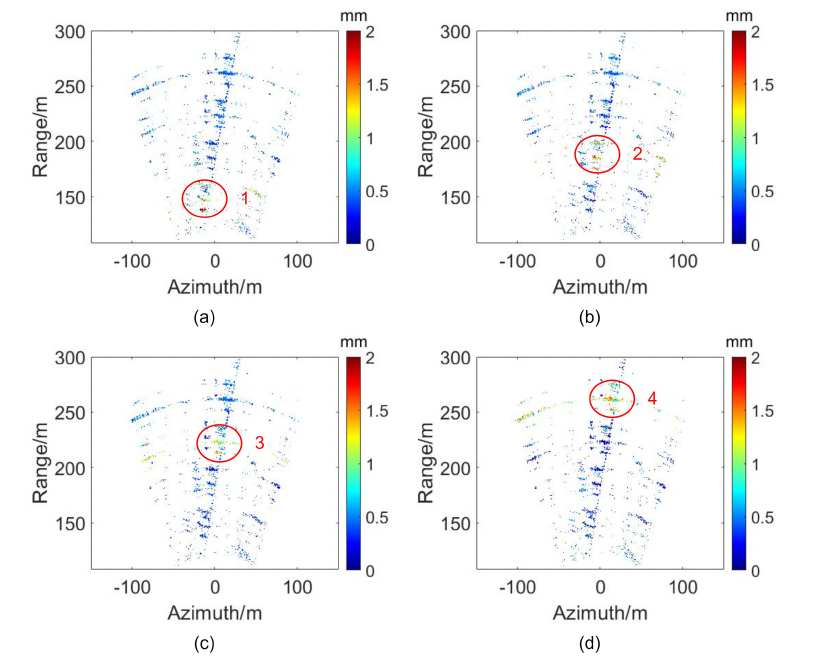
Figure 14. The bridge deformation diagram at different times on 27 August 2021. ( a ) The deformation at 11:16:03. ( b ) The deformation at 11:16:05. ( c ) The deformation at 11:16:07. ( d ) The deformation at